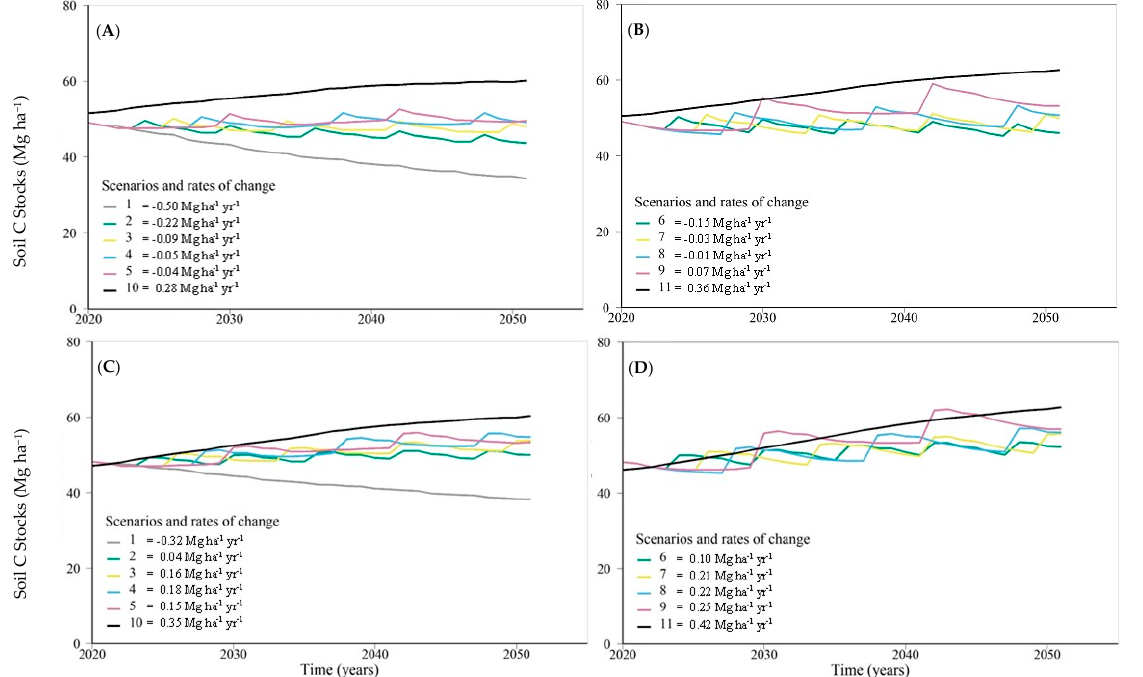
Figure 3. Long-term simulations of soil C stocks at 0–0.20 m depth of the hypothetical scenarios under the conventional system: ( A ) non-grazed, ( B ) grazed; and organic system: ( C ) non-grazed, ( D ) grazed. The reference for rates of SOC stocks change is the average of the measured (2017) soil C stocks in the conventional system: 51.01 Mg ha − 1 ( n = 6); and organic system: 48.81 Mg ha − 1 ( n = 6). The numbers 1–11 represent hypothetical scenarios as described in Section 2.6 “Long-term scenarios”.